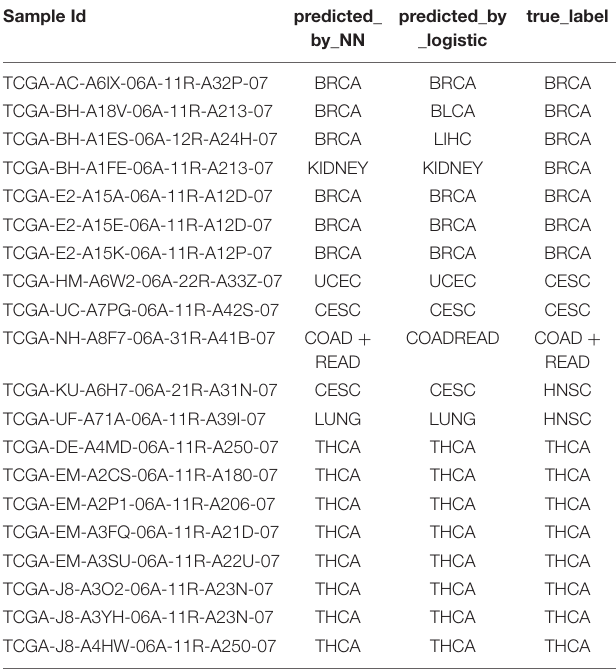
TABLE 5 | The performance on metastatic samples of the neural network trained on the primary √